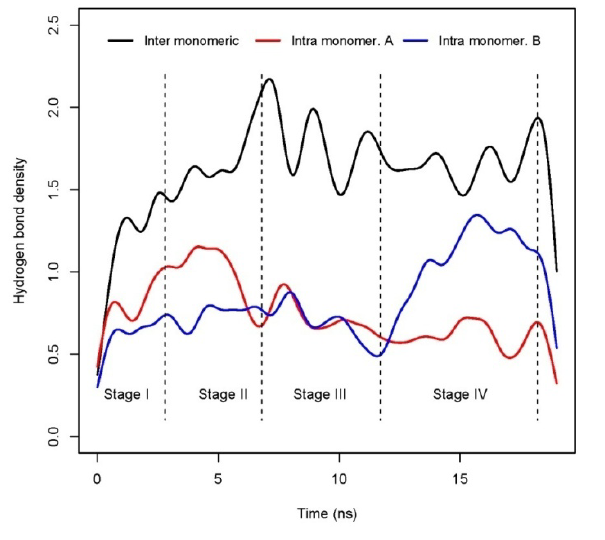
Figure 6. Evolution of hydrogen bond density for inter monomeric and intra monomeric